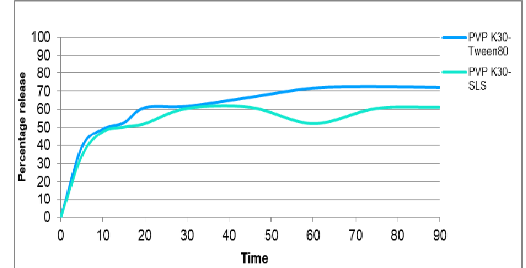
Figure 4. Influence of addition of co-stabilizer to PVP K30 on release profile in 0.1N HCl and 37  C